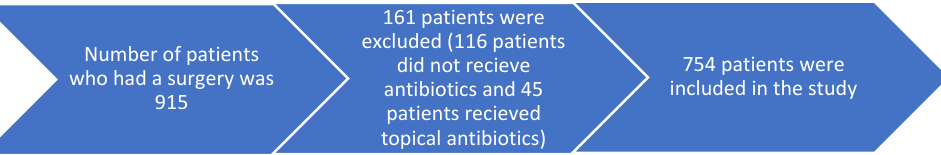
Figure 1. The number of patients included in this study.